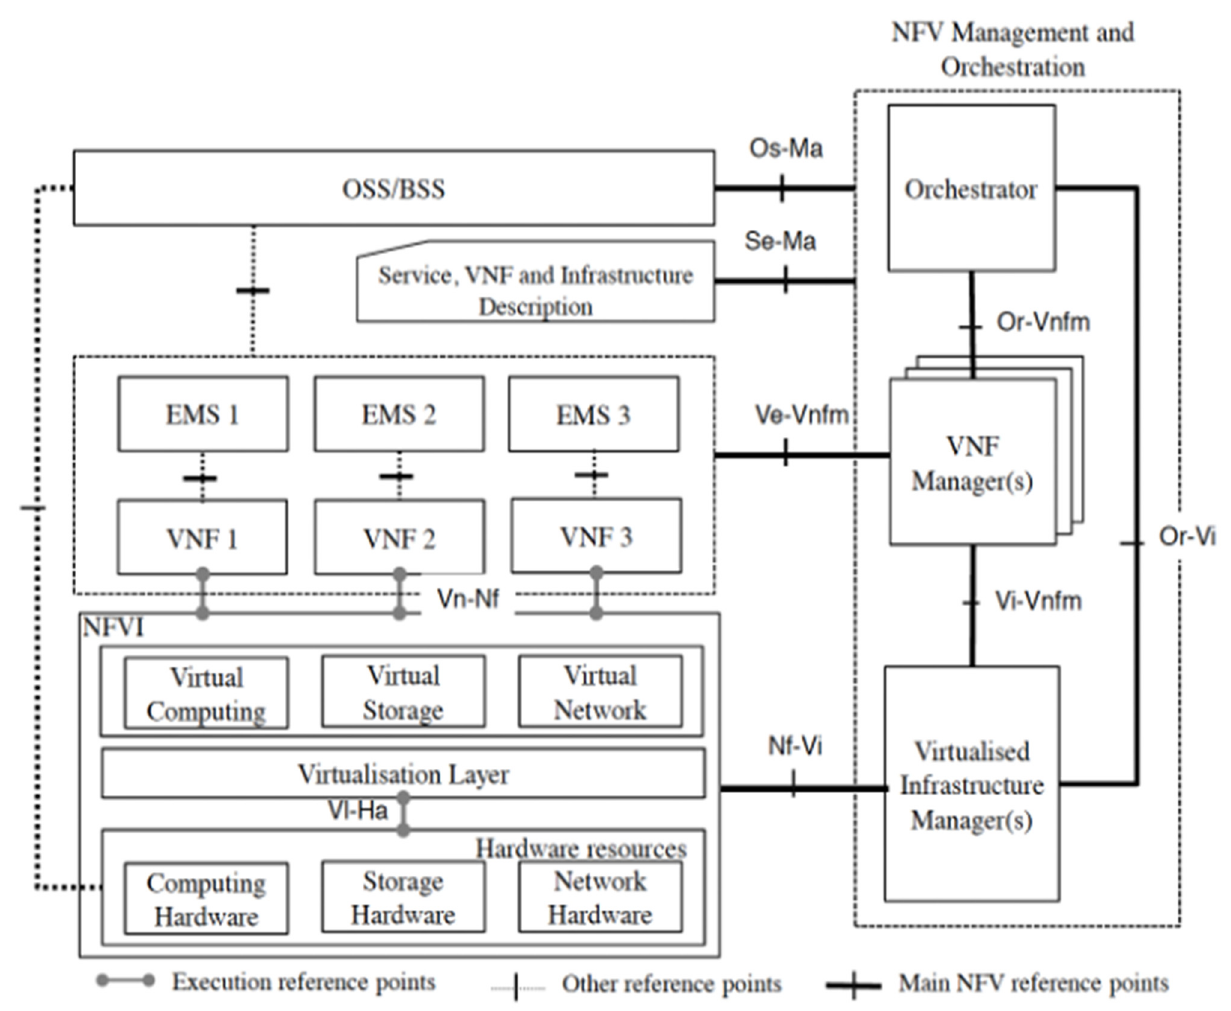
Figure 1. NFV Reference Architecture Framework [20].